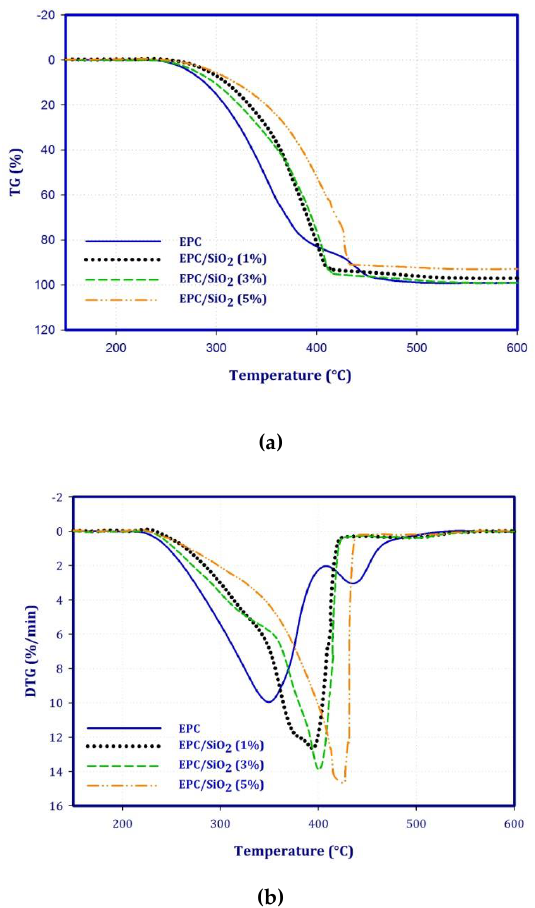
Figure 5. The thermo-oxidative degradation curves for the EPC, and its nanocomposites with various weight percent of SiO 2 nanoparticles. ( a ) mass loss, ( b ) derivative of mass loss . Table 2. The thermal properties of EPC and EPC/SiO 2 nanocomposites.